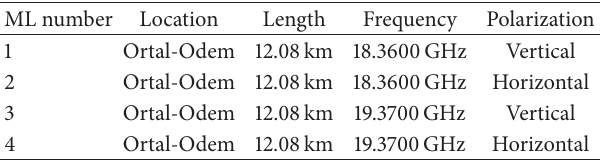
Table 1: Available microwave